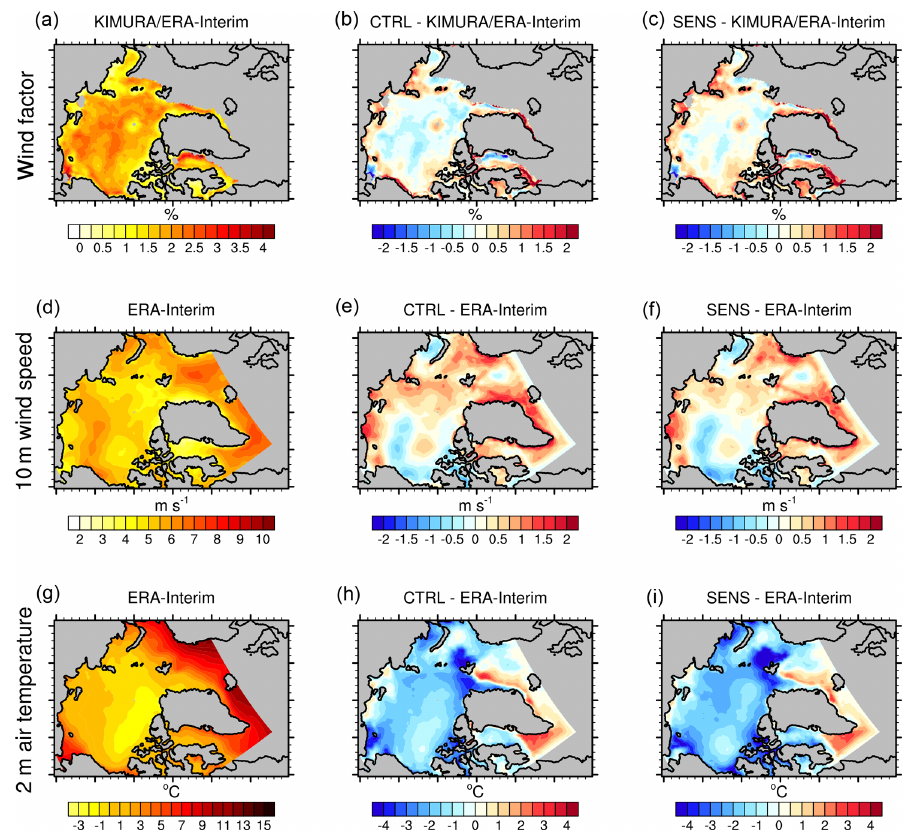
Figure 11. The 2007 summer (JJAS) (a) wind factor, (d) 10m wind speed, and (g) 2m air temperature from ERA-Interim (KIMURA sea ice drift is used for wind factor calculation). (b) Wind factor, (e) 10m wind speed, and (h) 2m air temperature differences between the CTRL experiment and ERA-Interim (KIMURA and ERA-Interim for the wind factor). Panels (c) , (f) , and (i) are the same as (b) , (e) , and (h) but show the differences between the SENS experiment and ERA-Interim (KIMURA and ERA-Interim for the wind